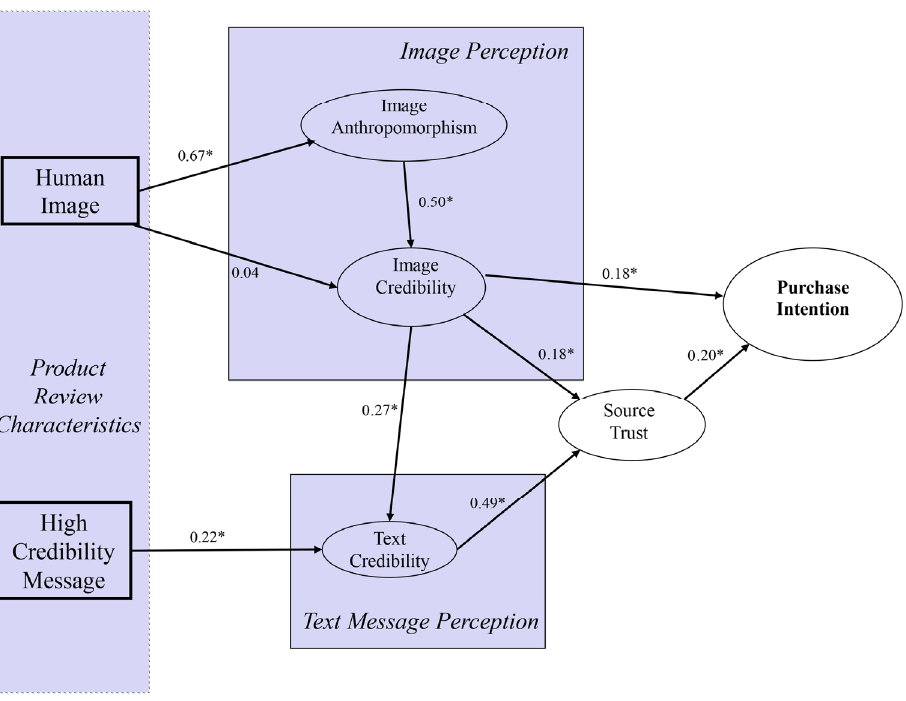
Figure 3. Path model.